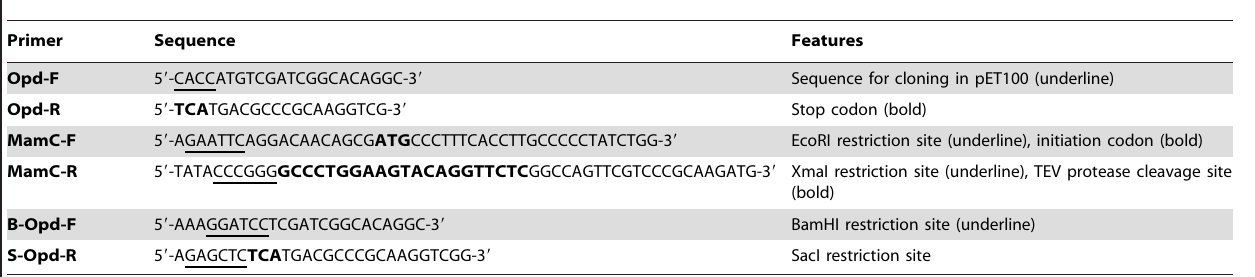
Table 1. Primers used for the mamC::opd transcriptional fusion.